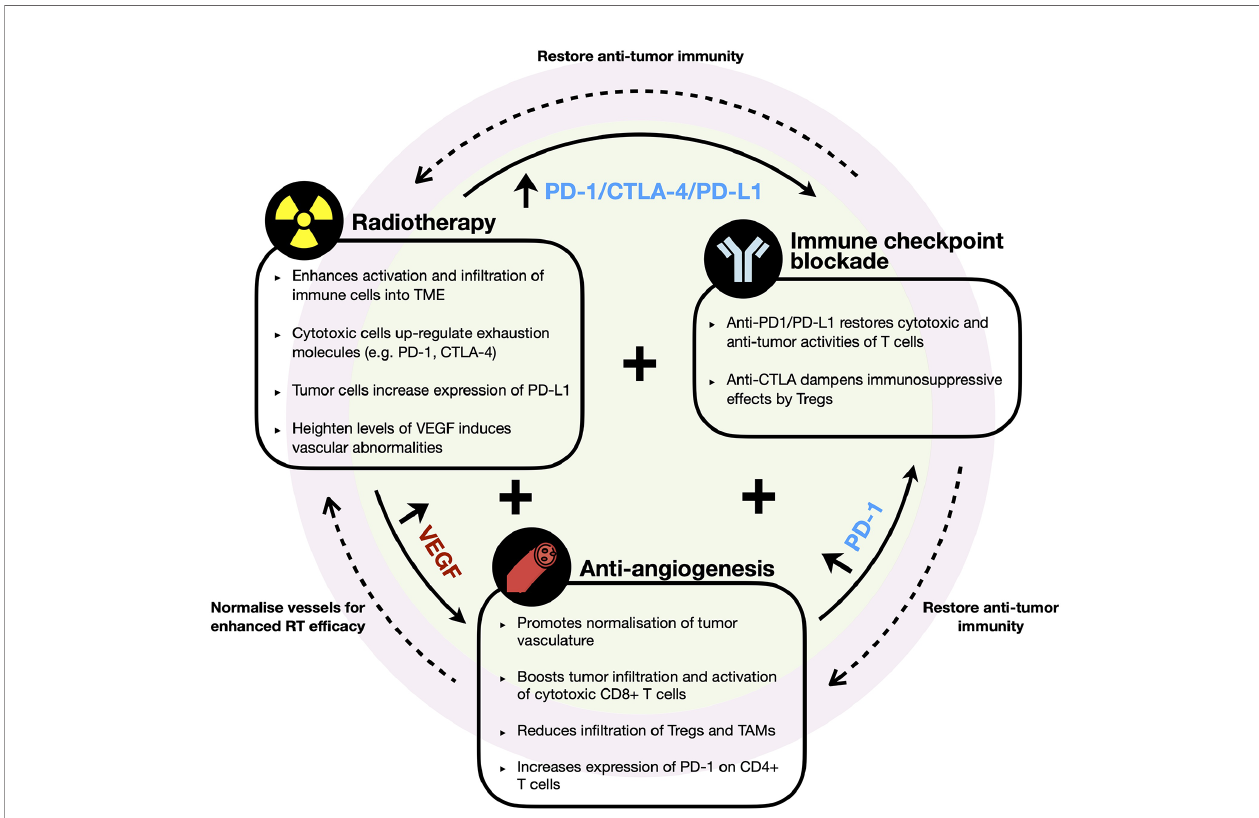
FIGURE 3 | Rationale of combination therapy with radiotherapy, immune checkpoint blockade, and anti-angiogenesis agents. Diagram illustrates the key immune modifying effects by each therapeutic agent and the potential synergetic effects of their combination in HCC. RT enhances immune in fi ltrates into TME but induces upregulation of immune checkpoint molecules (e.g. PD-1, PD-L1, and CTLA-4) and VEGF. Anti-VEGF promotes normalization of vessel formation, which improves ef fi cacy of RT and/or further boosts in fi ltration of cytotoxic cells into TME but increases PD-1 expression by CD4+ T cells. Synergistic combination with ICB restores and further enhances anti-tumor immune responses to improve ef fi cacy of RT and anti-VEGF